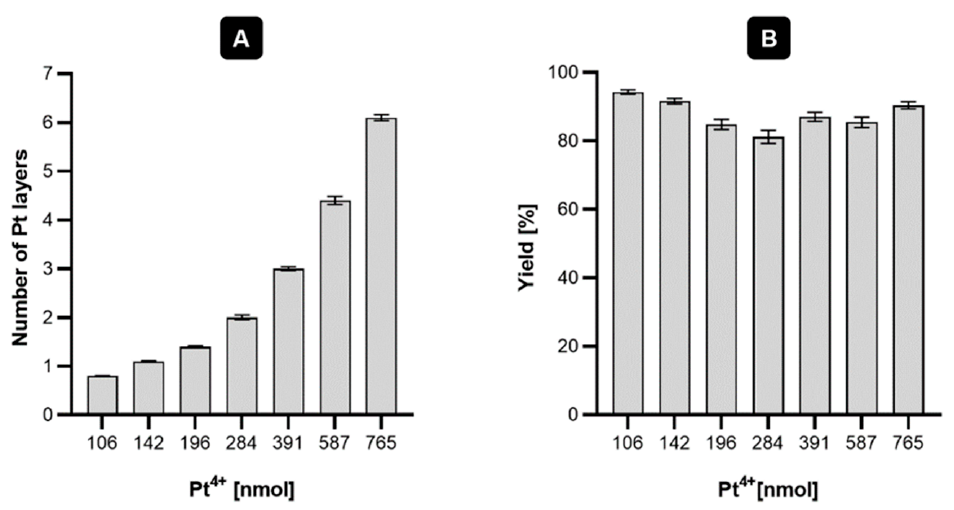
Figure 2. Digital image of synthesized AuNPs ( A ), Au@Pt–monolayer ( B ) and Au@Pt–multilayer ( C ). Table 1. Hydrodynamic diameter and zeta potential of AuNPs and AuNPs covered by ~1 and ~6 layers of Pt atoms.